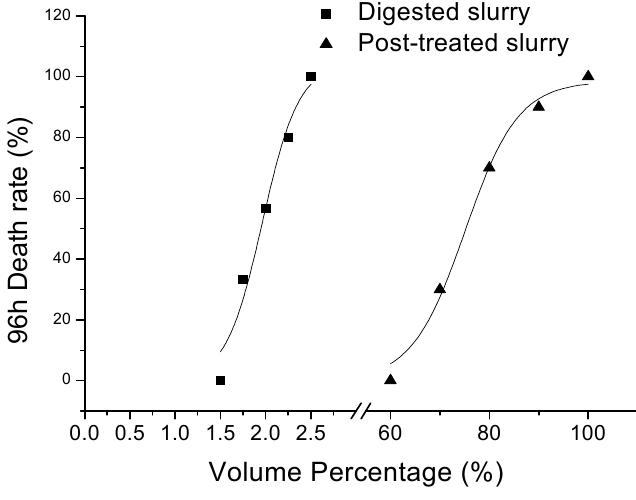
Figure 2. Plot of 96h-death rate vs . volume percentage of digested and post-treated slurry where the curves were fitted to Logistic